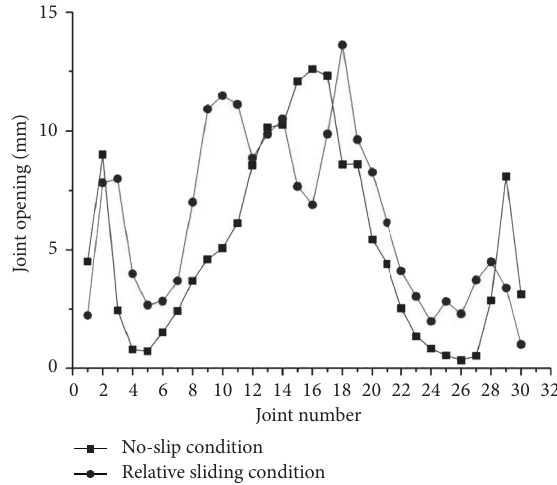
Figure 18: Contraction joint slippage at the upstream and downstream side of the dam crest for relative sliding condition.